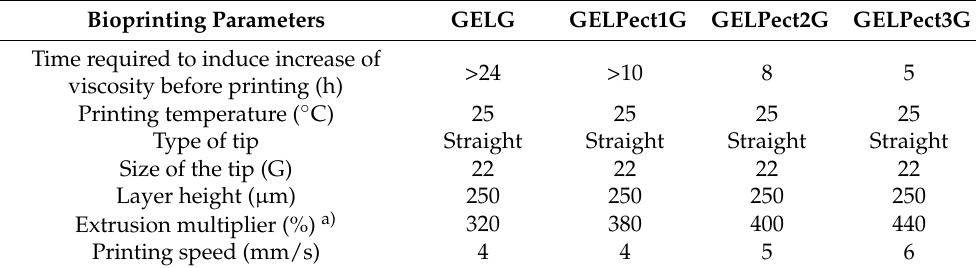
Table 2. Bioprinting parameters used to bioprint GELG, GELPect1G, GELPect2G, and GELPect3G biomaterial